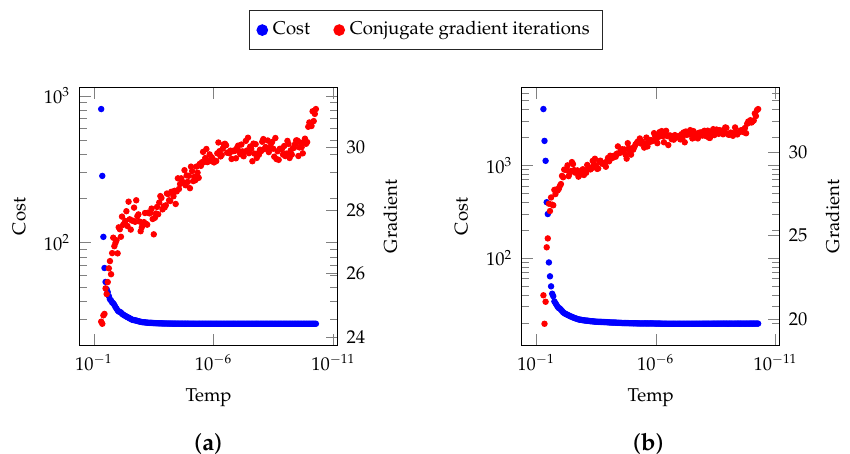
Figure 7. The graphs in blue show the cost function average per temperature. It represents the convergence of the SA. The graphs show a short exploration phase and a longer refinement phase. The graphs in red show the number of conjugated gradients iterations average per temperature. ( a ) Linear arrangement. ( b ) Triangular arrangement. Table 5: Results of tests for the two arrangements. The final cost and the total number of cost function evaluations